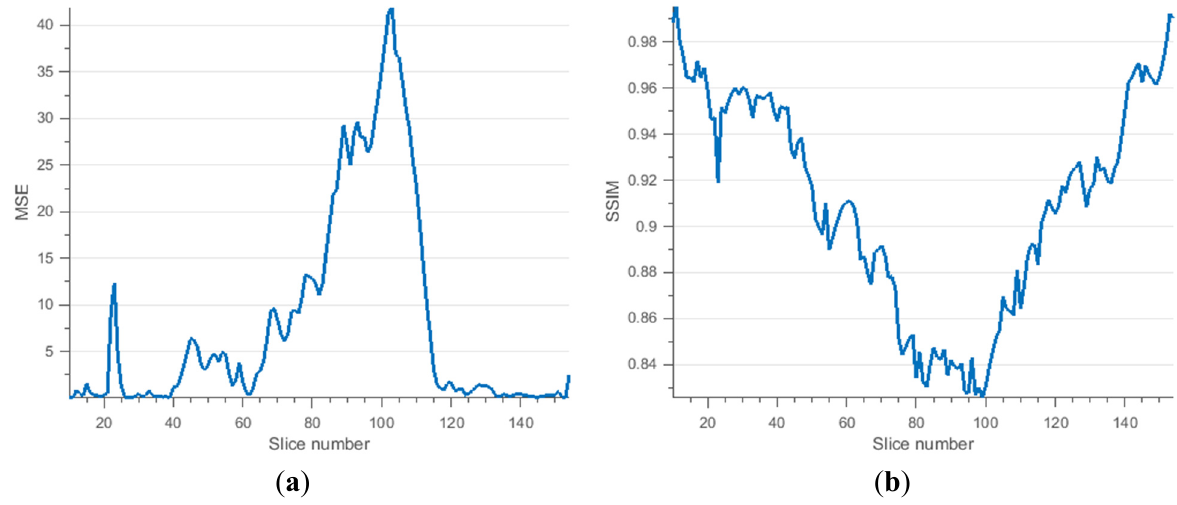
Figure 16. ( a ) An MSE comparison of the estimated fuzzy label mask to the ground truth for severe MS lesion brain data. The profile follows Figure 9 due to consistent underestimation of the fuzzy labels. ( b ) An SSIM comparison of the same fuzzy label